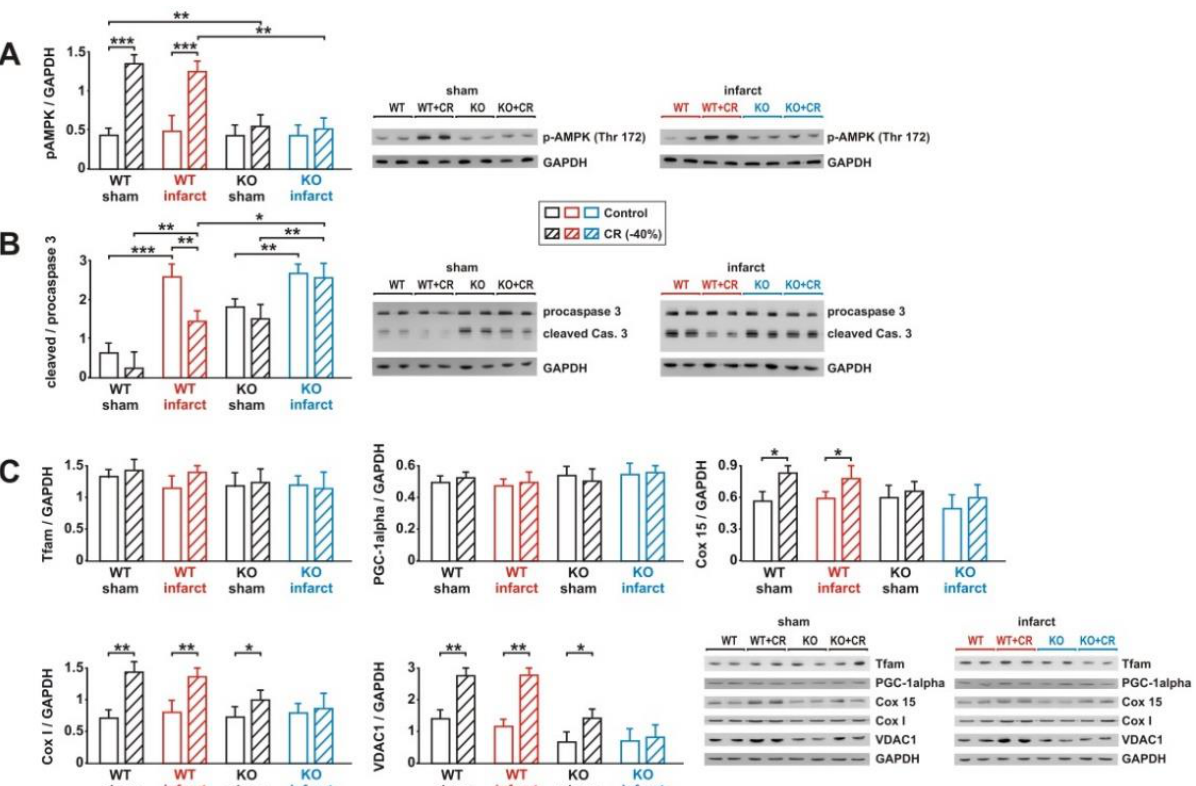
Figure 8. Effect of 8 weeks CR on AMPK activation, apoptosis, and mitochondrial biogenesis. ( A ): Representative Western blots and quantification of phosphorylation of AMPK (at Thr172), normalized to GAPDH, in WT and KO sham or infarct mice, following 8 weeks of control or CR diets. ( B ): Representative Western blots and quantification of full-length and cleaved, activated caspase-3. GAPDH served as loading control. ( C ): Representative Western blots and quantification of protein expression of Tfam, PGC-1alpha, mitochondrial components of complex IV (Cox 15 and I), and VDAC1, normalized to GAPDH, in LV tissue. All data are mean ± SEM. n = 6–8 animals per group, *: p < 0.05; **: p < 0.01; ***: p < 0.001. Full size blots are provided in Supplementary Figure S8.